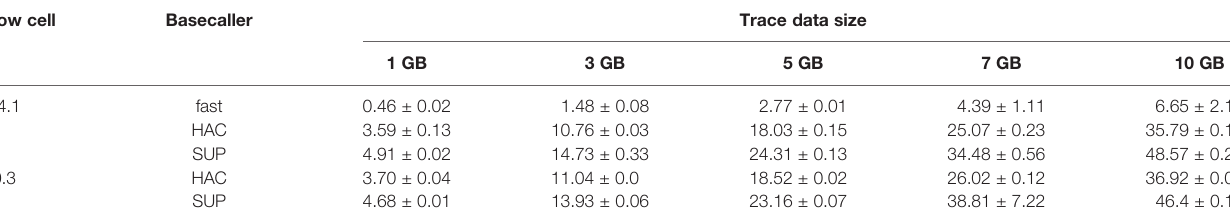
Table values represent the mean ± STD of minutes needed to call trace